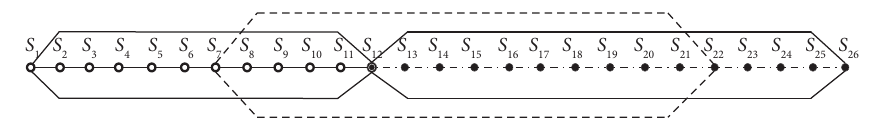
Figure 12: Diagram of the optimal routing schemes. Table 7: Solution results of different models.